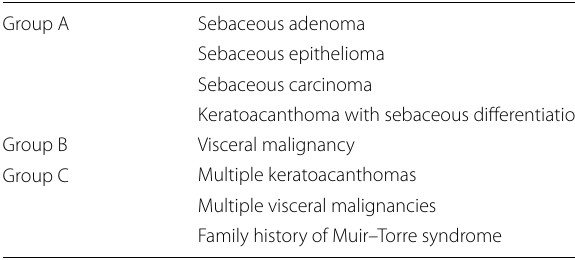
Diagnosis requires one criterion from group A and group B, or all three from group C, in absence of other predisposing factors, such as radiotherapy for childhood retinoblastoma associated with eyelid sebaceous carcinoma, AIDS, and Kaposi’s sarcoma (in which case neither the Kaposi’s sarcoma nor a